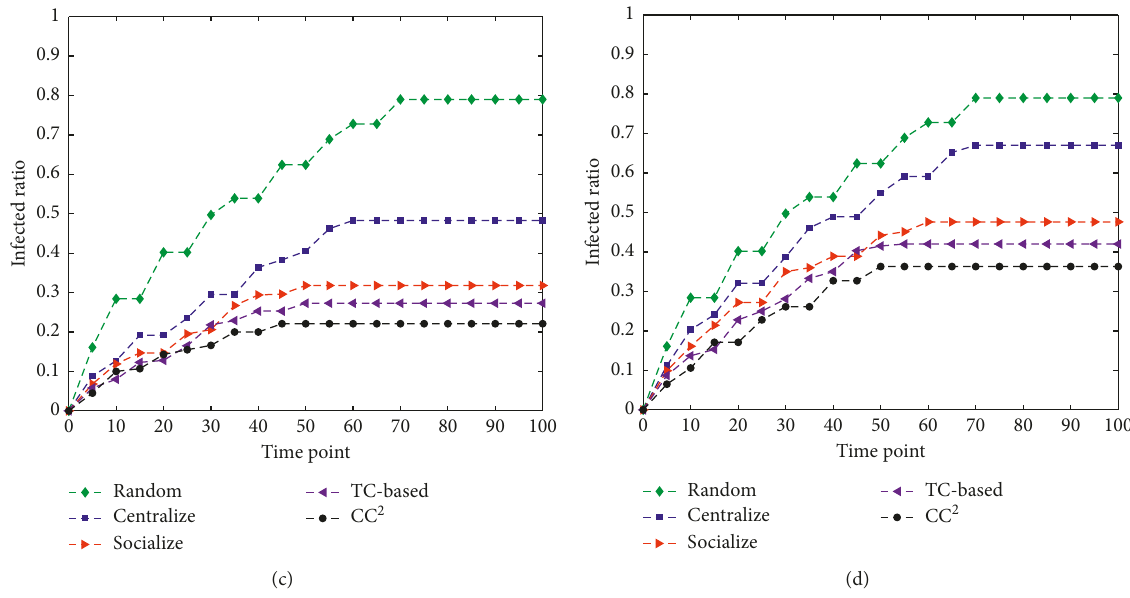
Figure 13: Performance comparison of different coping scheme with 5% patching nodes on the MIT Reality network with initially infected